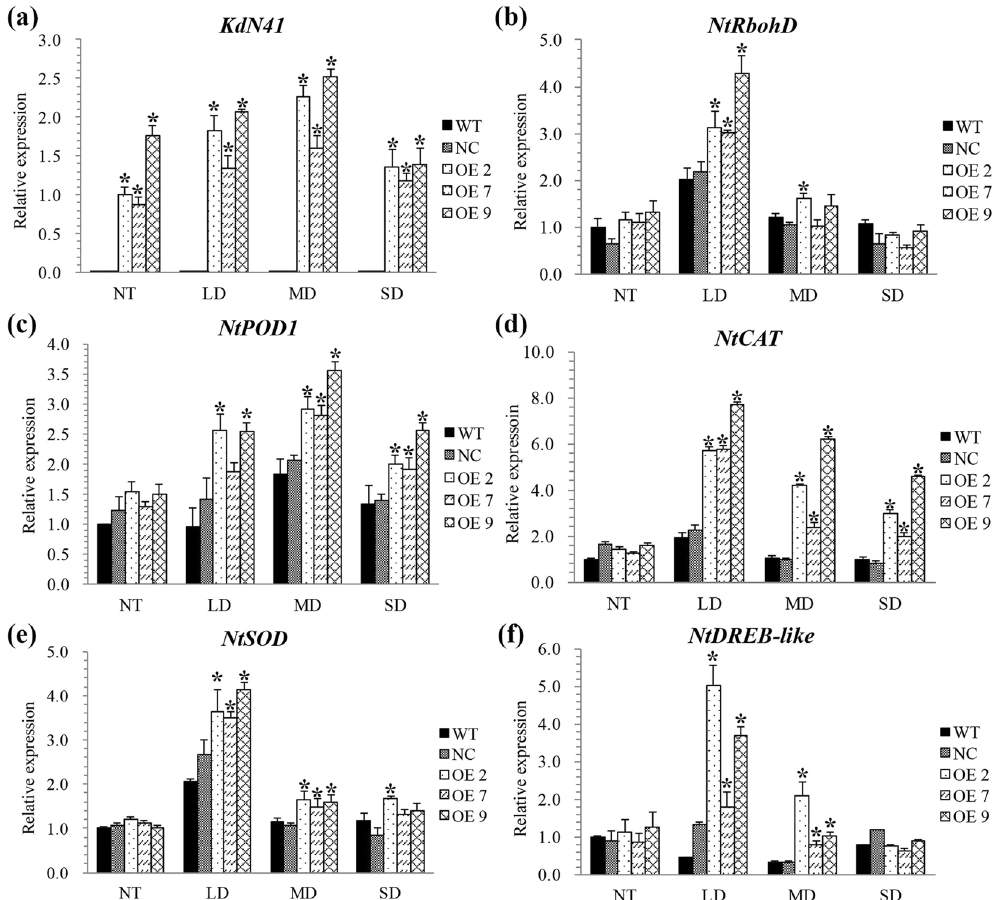
Figure 8. Relative expressions of drought resistance related genes in 35S::N41 (OE), wild type (WT) and NC (negative control) tobacco plants in response to increasing levels of drought stress, NT (non-treatment), LD (light drought), MD (medium drought), and SD (severe drought). Errors bars represented ± SD (standard deviations). * Indicated a significant difference compared to WT (Duncan’s multiple range test p < 0.05). The expression level of WT group under NT was treated as reference and calculated as